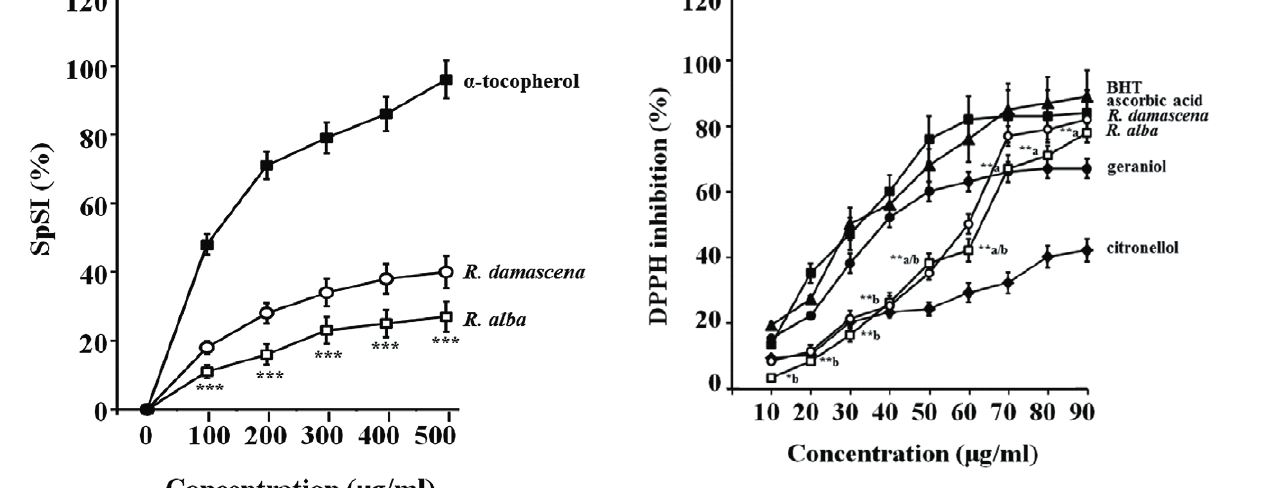
Figure 2. DPPH scavenging activity (%) at various concentrations (μg/ml) of Bulgarian Rosa alba L. essential oil and its main ingredi- ents geraniol and citronellol. The essential oil from Rosa damascena Mill. was used as a control. Data are expressed as mean ± SD of three independent experiments. ***p<0.001 compared with citron- ellol (a), compared with BHT and ascorbic acid